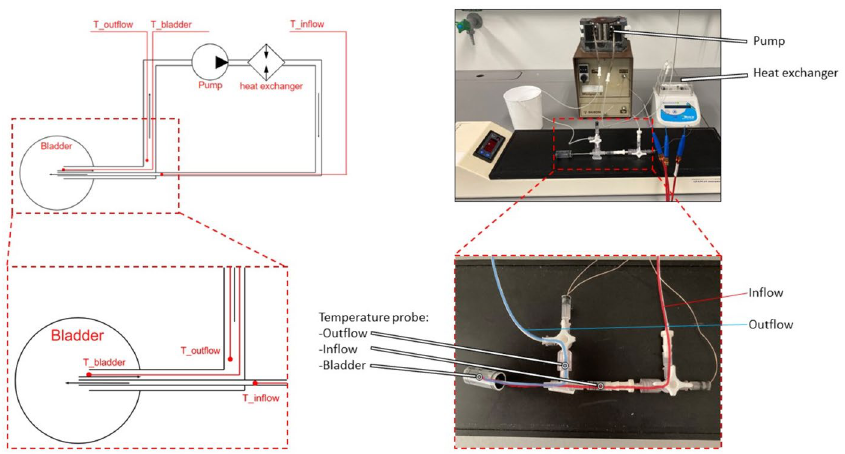
Figure 1. Overview of the HIVEC setup. Top left, schematic overview of setup showing the semi-open circulatory loop, flow direction and location of temperature probes. Bottom left, zoom-in of bladder and double- lumen catheter showing placement of temperature probes in the inflow channel, bladder, and outflow channel. Top Right, overview of setup with the bladder phantom. Bottom right, bladder phantom with the double lumen catheter fully inserted. The liquid inflow trajectory is shown in red, the outflow in blue, and the tips of the temperature probes are marked with white